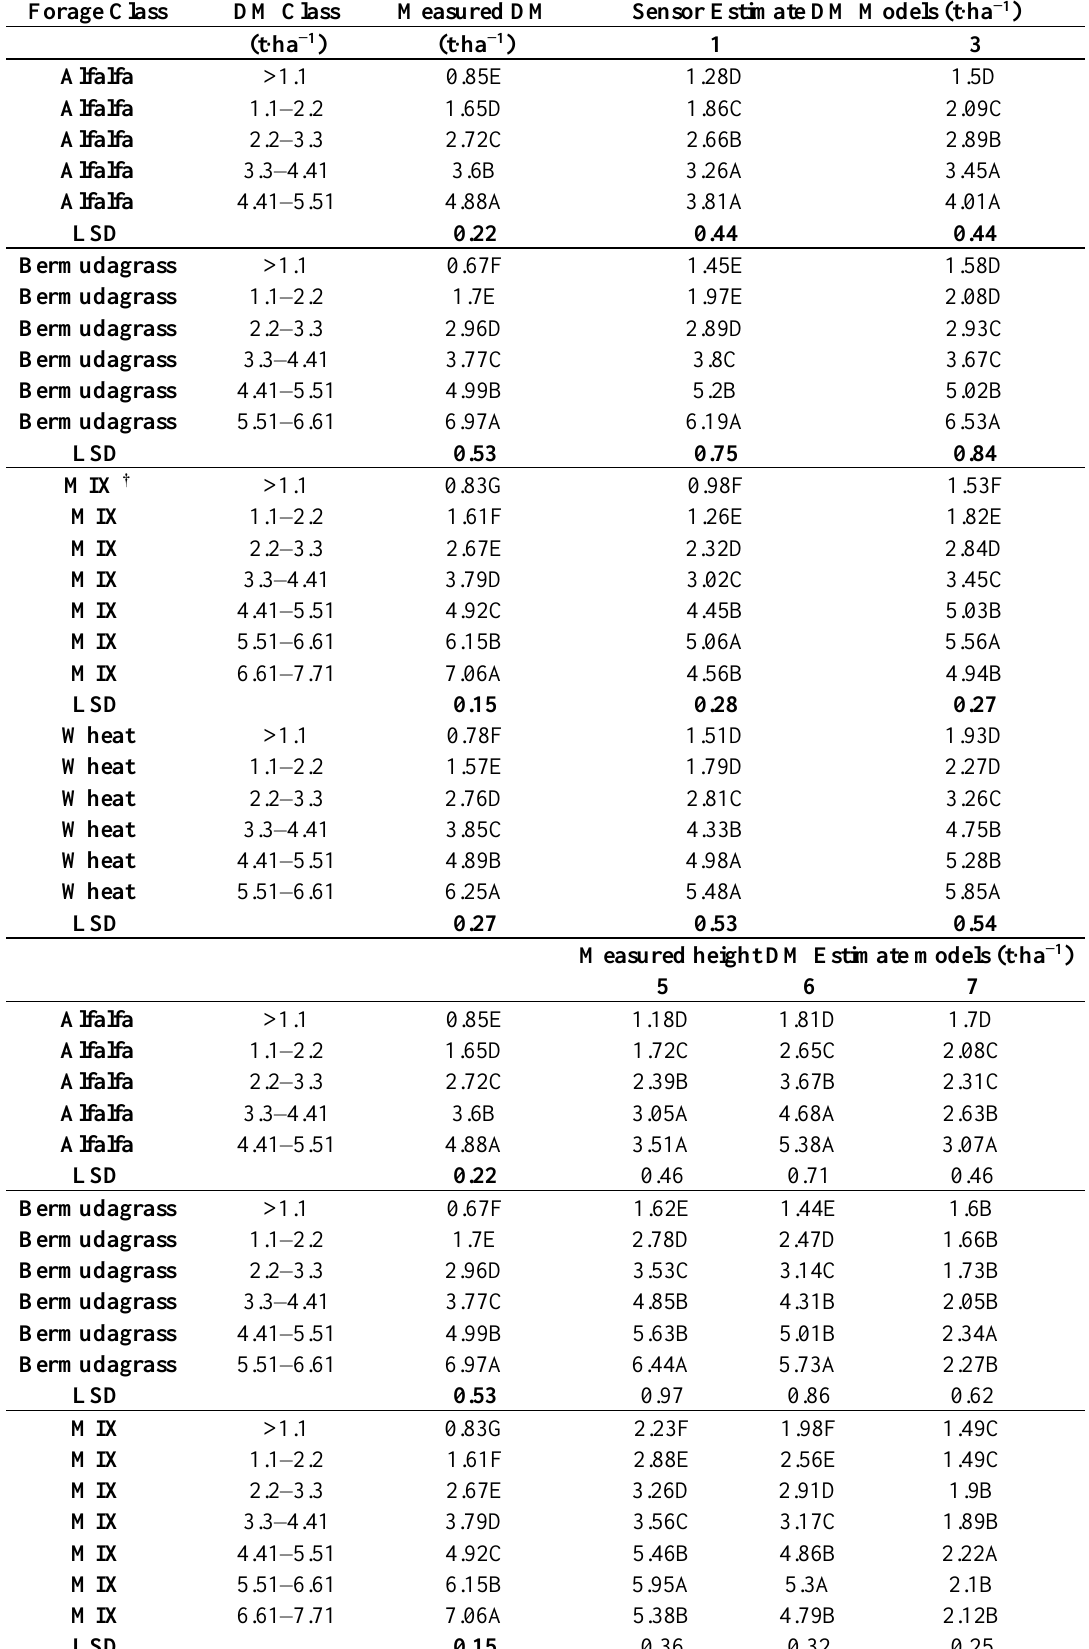
Table 6. Mean estimates and LSD groupings for destructively measured DM and sensor modeled estimates of DM. † MIX-Mixture of alfalfa and bermudagrass. Forage